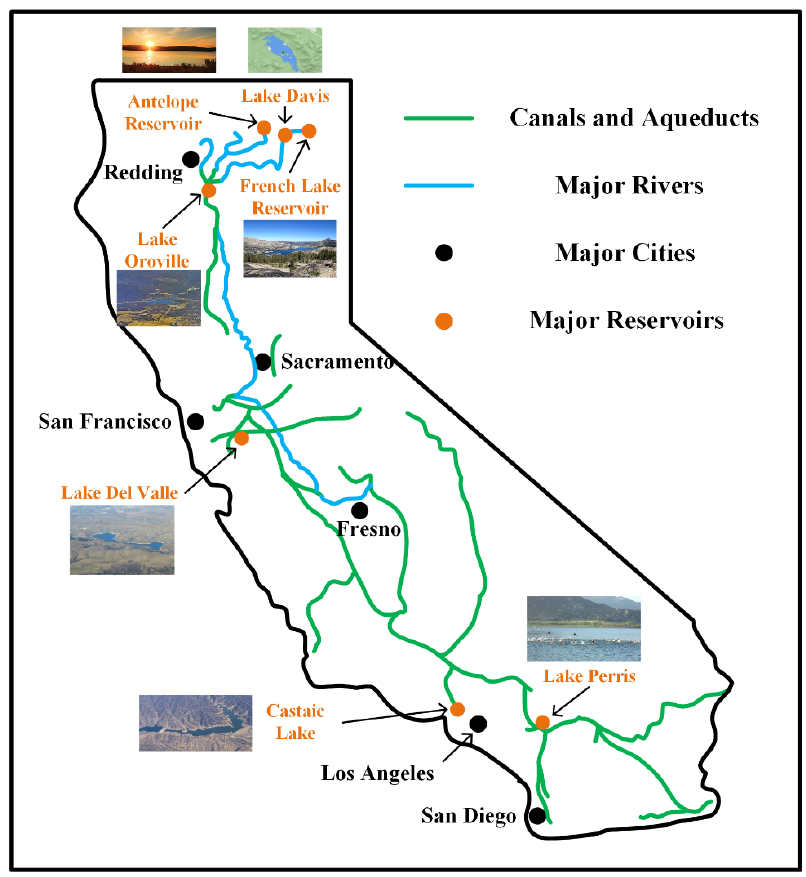
Figure 1. Major cascade reservoirs of the California State Water Project (SWP).